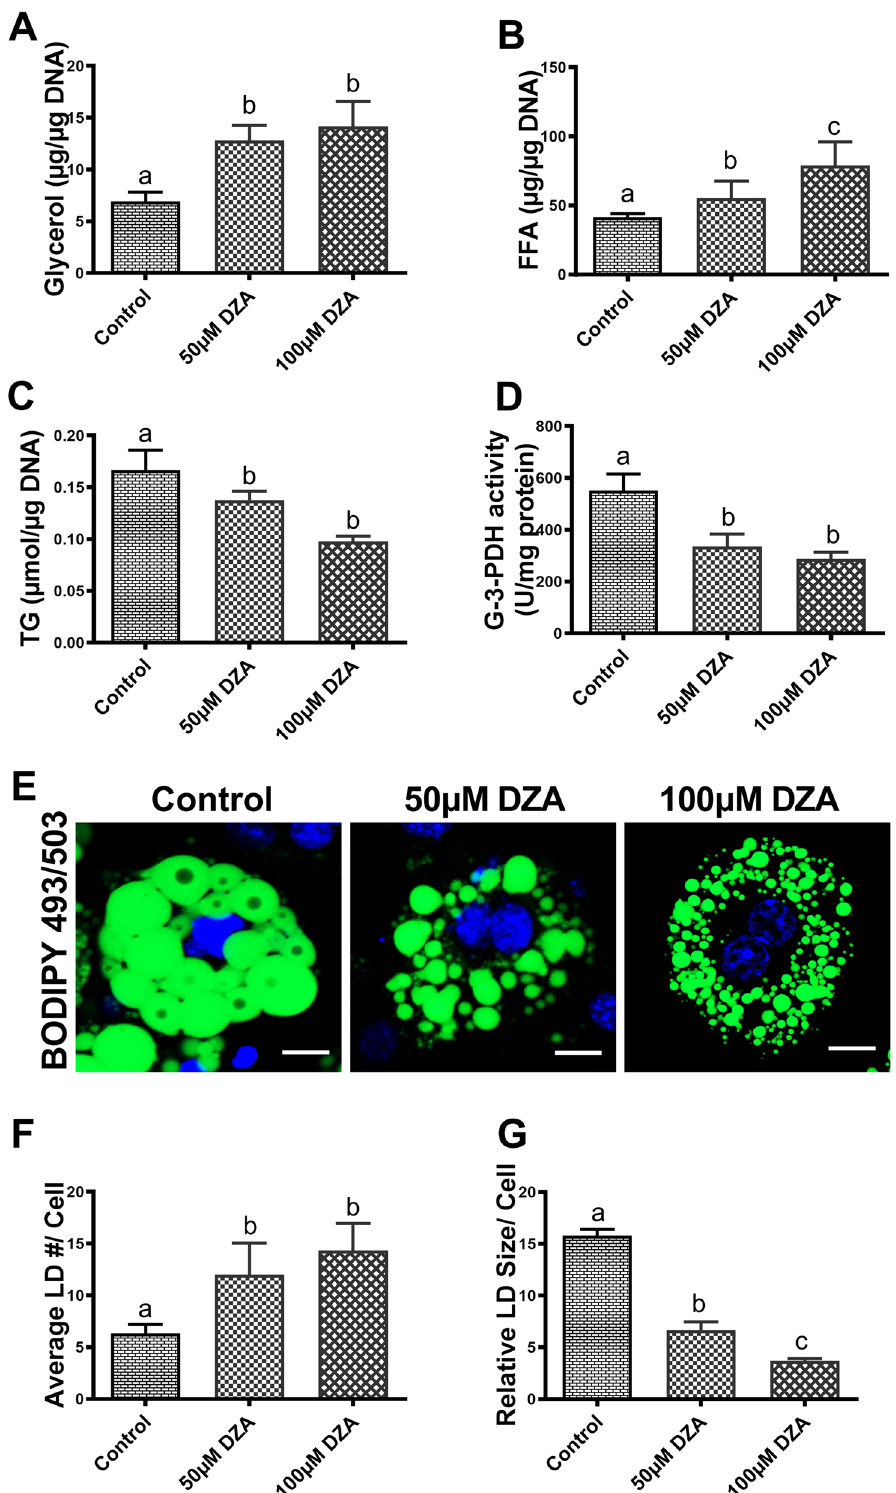
Figure 1. DZA stimulates lipolysis in 3T3-L1 adipocytes. Quantification of ( A ) glycerol and ( B ) free fatty acid (FFA) levels in the medium normalized to cellular DNA and expressed as µg/µg DNA, ( C ) cellular triglyceride (TG) content normalized to cellular DNA and expressed as µmole/µg DNA and ( D ) glycerol-3-phosphate dehydrogenase (G-3-PDH) activity expressed as U/mg protein (1 unit of activity represents the oxidation amount of 1.0 nmol/L per minute) in control and DZA-treated 3T3- L1 adipocytes (n = 8). ( E ) Representative confocal images of BODIPY 493/503 and DAPI (nucleus – blue) stained control and DZA-treated 3T3-L1 adipocytes (Scale bar—20 µm). Distribution of lipid droplets (LDs, stained green) in 3T3-L1 adipocytes, n = 4 experiments; images of 27 random cells from each treatment group per experiment were captured and analysed for ( F ) Average # of LDs per cell and ( G ) relative size (diameter) of LDs/cell. Data are presented as the mean ± SEM; values not sharing a common letter significantly differ from each other at p ≤